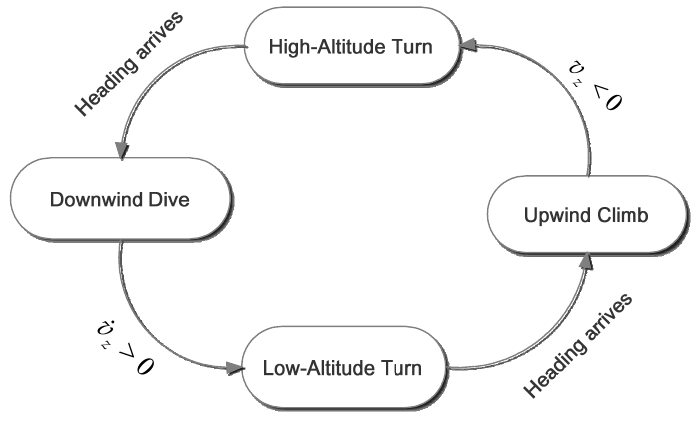
Figure 6. Transfer logic among the four phases in the bio-inspired strategy for implementing the Raleigh cycle.